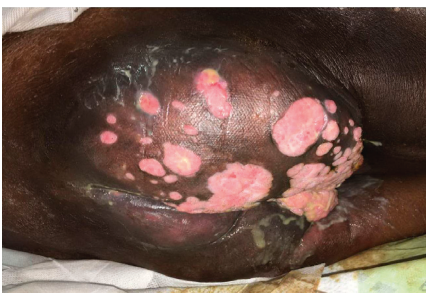
Figure 1: Cauliflower-like fungating mass with foul-smelling purulent discharge.